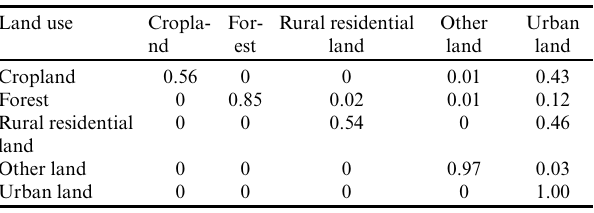
Table 1 . Markov transition probability matrix in central district between 2000 and 2005.